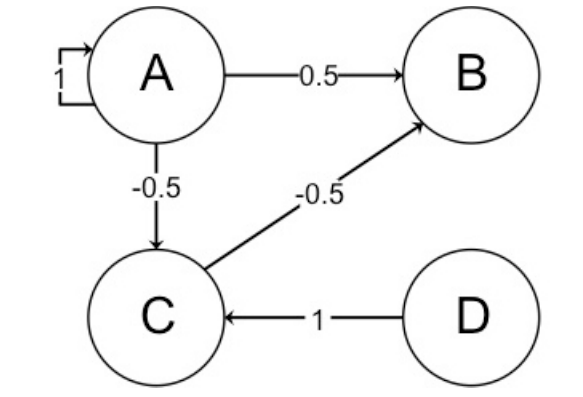
Fig. 1 . An example of a simple fuzzy cognitive map (FCM), illustrating weighted edge relationships (-1, 1) between system elements A, B, C, and